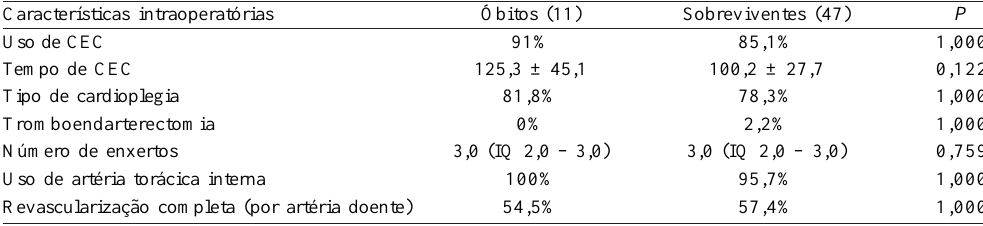
Tabela 1. C. Características